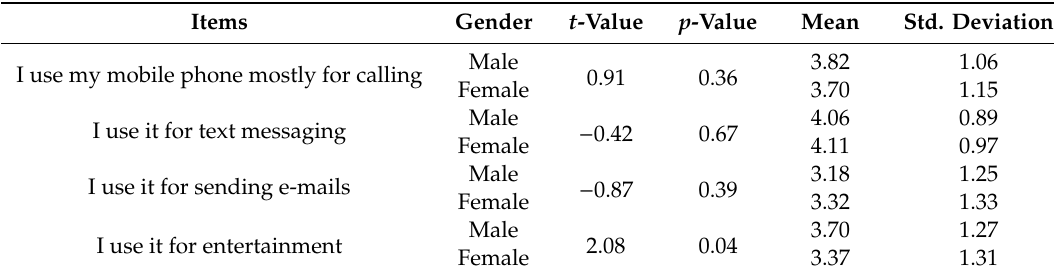
Table 5. T-test for use of mobile phone feature. Table 5. T -test for use of mobile phone